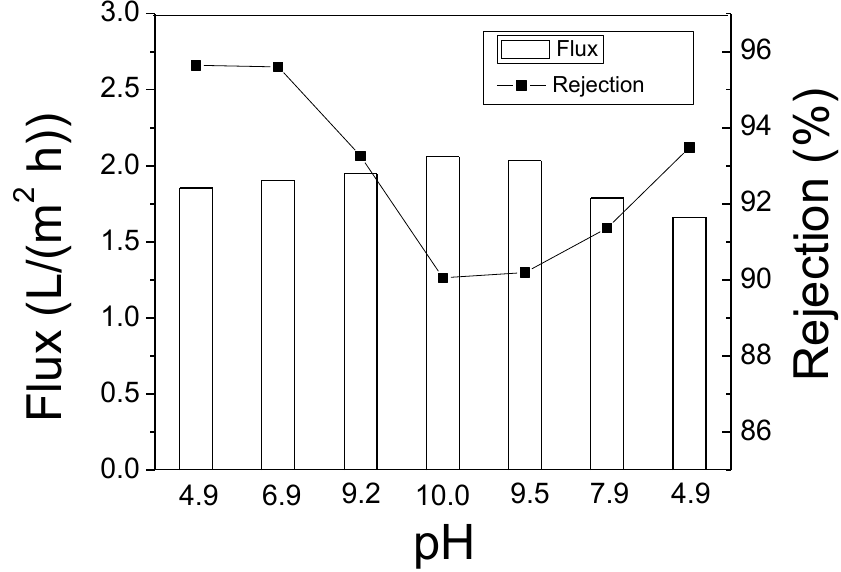
Figure 9. Rejection and flux of the PBI HF module (air gap = 2.5”, 6.4 cm) varied by solution pH (pH was adjusted by adding 1.0 mol/L NaOH or 1.0 mol/L HCl; the test conditions were 2000 ppm NaCl, 300 psi or 20.7 bar, and 25 ± 2 °C).